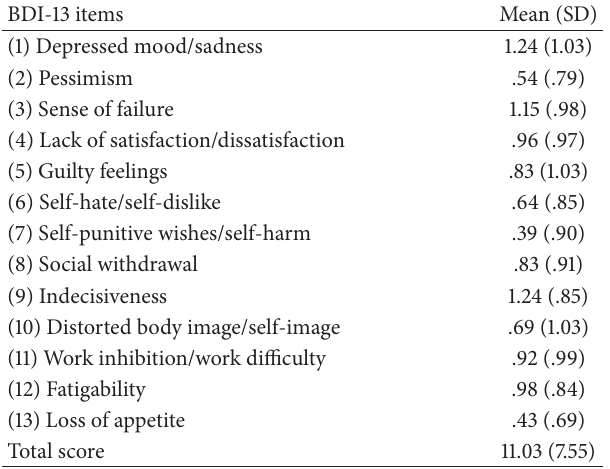
Table 1: Means and standard deviations of BDI-13 items. BDI-13